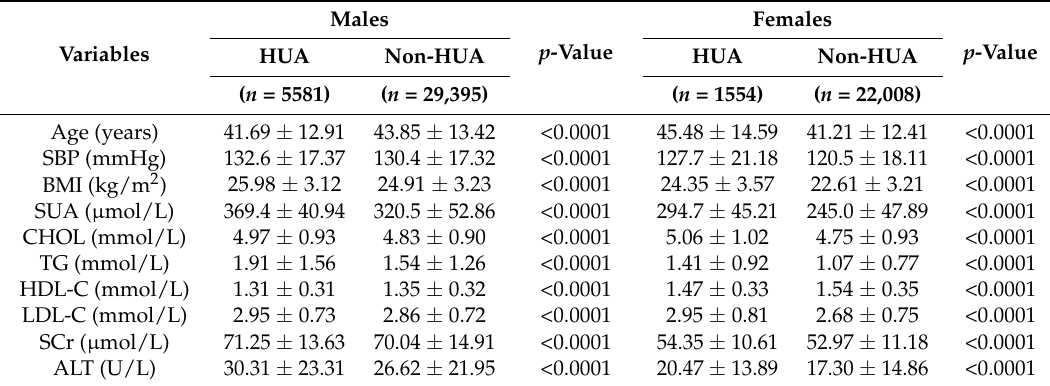
Table 1. Baseline characteristics by incident hyperuricemia status of males and females.